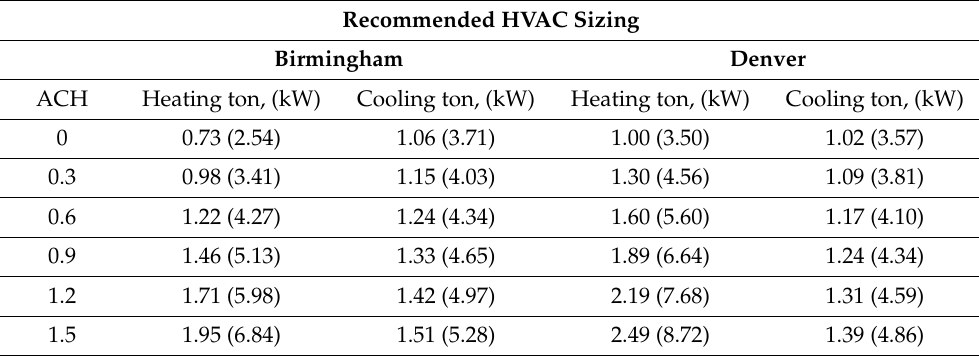
Table 8. The influence of varying air infiltration on the recommended HVAC sizing.